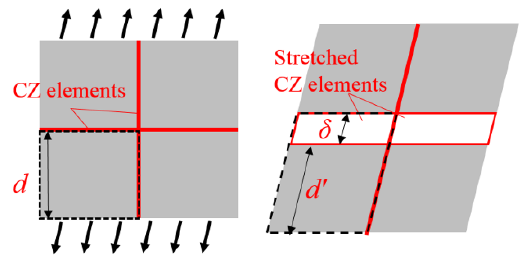
Figure 3. A schematic drawing to show unrealistic deformation due to the deflection of cohesive zone (CZ) elements.